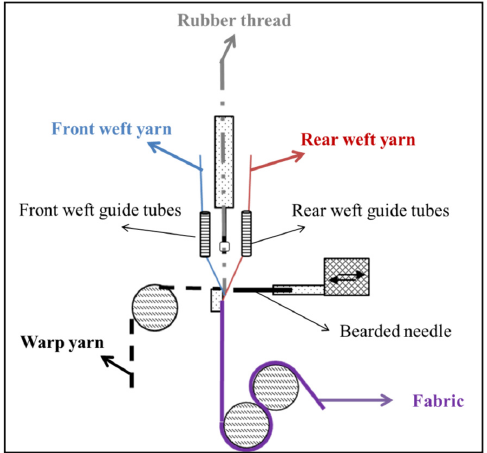
Figure 3. Principle of producing warp ‐ knitted fabrics using a crochet knitting machine.